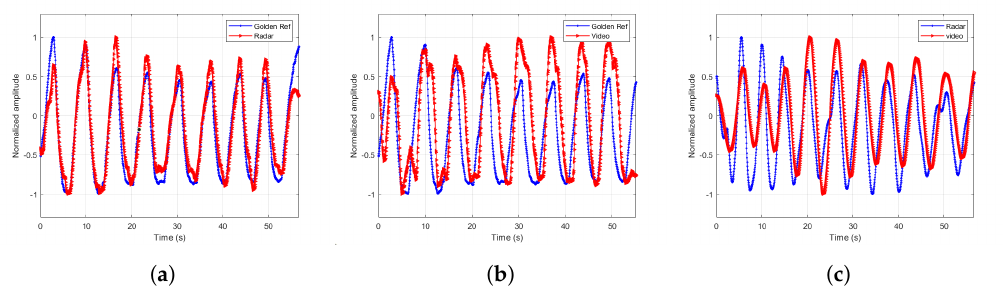
Figure 7. Extracted signals comparisons for breathing rate of 9.37 BPM. ( a ) Radar and ground truth signals. ( b ) Depth and ground truth signals. ( c ) Radar and depth signals.